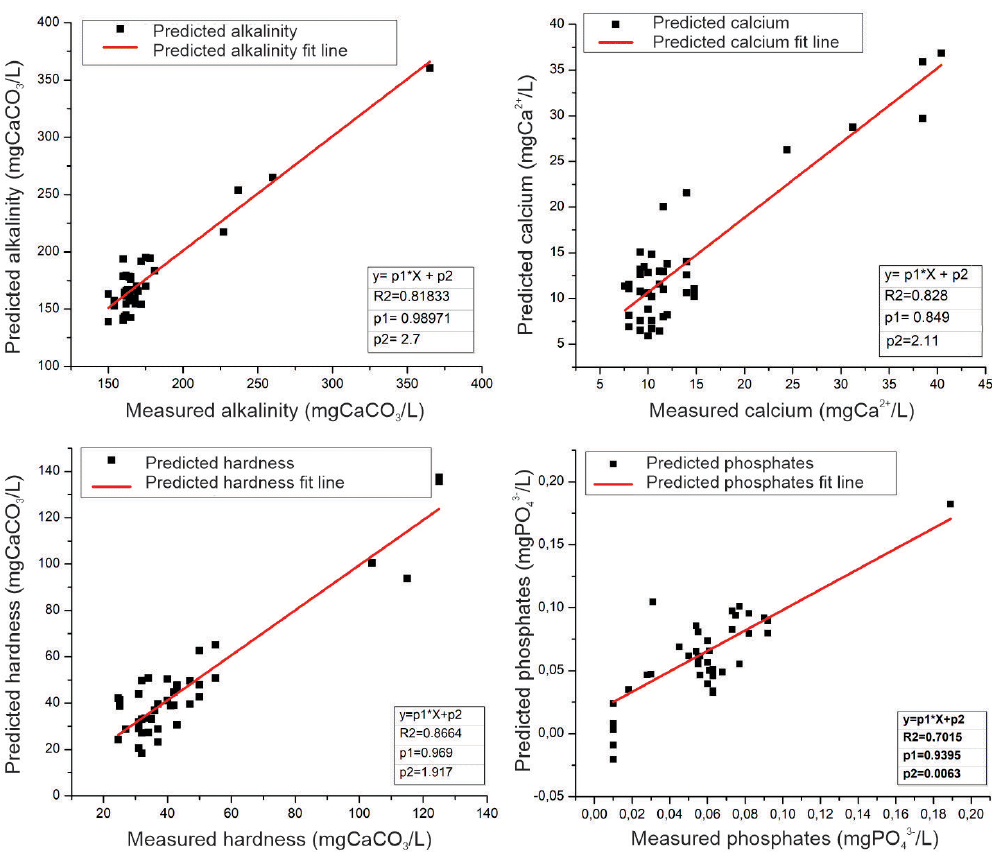
Figure 6. Regression models of physicochemical parameters (alkalinity, calcium, hardness, and phosphates) generated by smart electronic tongue and traditional methods of chemical